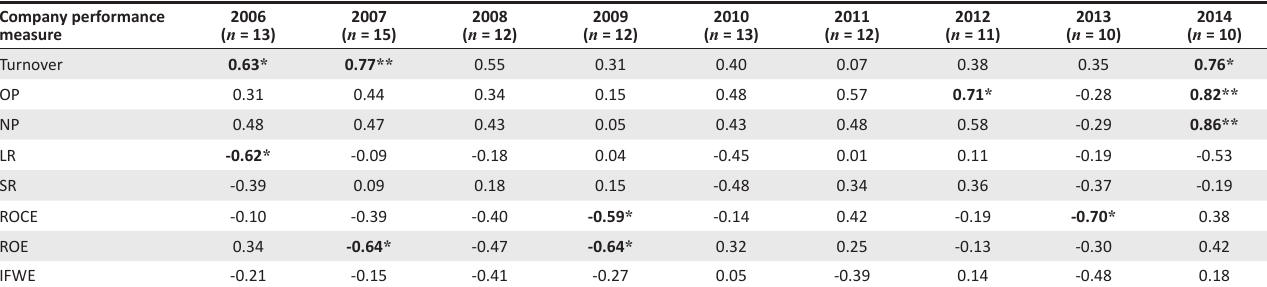
TABLE 4: Short-term incentives and state-owned companies’ performance. Company performance